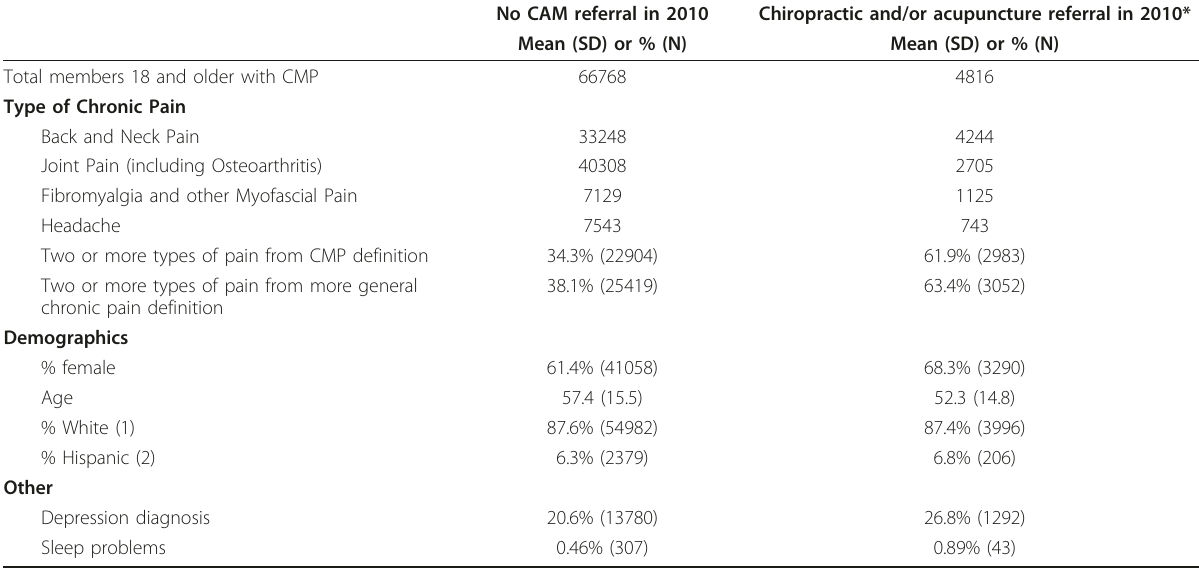
Table 2 KPNW Health Plan Members with CMP in